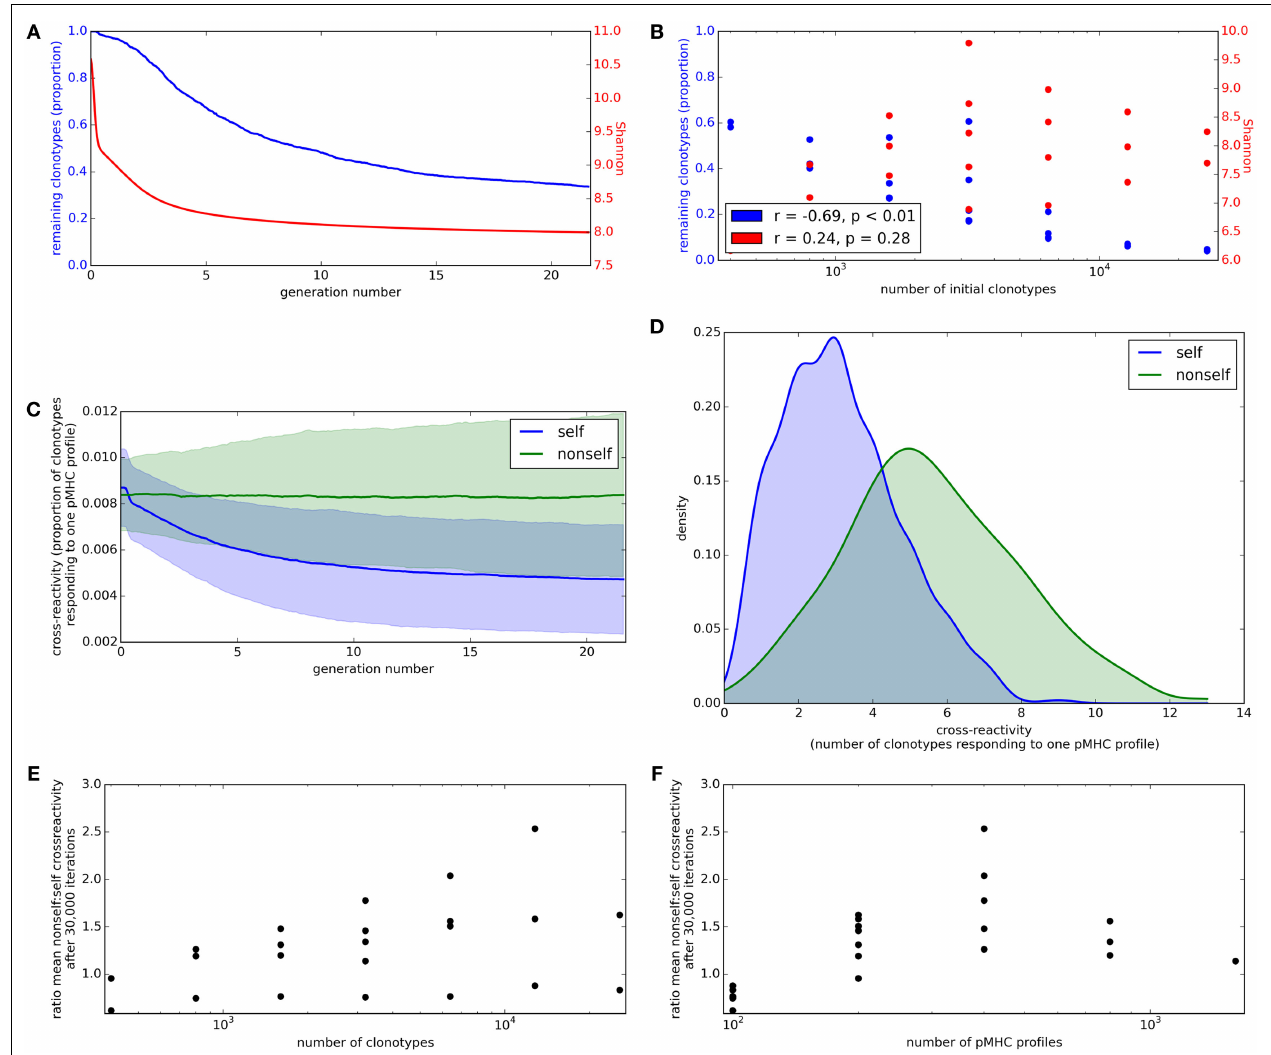
FIGURE 4 | Clonotype diversity and pMHC profile cross-reactivity are preserved by the update algorithm . (A) Blue: The proportion of clonotypes (after positive selection) that are present over time during simulation of the update algorithm. Red: The Shannon entropy of the repertoire over time. Simulation implemented with N = 1,600 and M = 400. (B) Relationship between number of clonotypes in the simulation and proportion of clonotypes remaining (blue) or Shannon entropy of the repertoire (red) after 30,000 iterations of the update algorithm. Simulation implemented with values of N between 400 and 25,600 and M between 100 and 800, with M < N . (C) Cross-reactivity of T cell clonotypes against self (blue) and non-self (green) pMHC profiles over time, run with N = 3,200 and M = 400. Cross-reactivity is measured as the proportion of present clonotypes that have non-zero binding strength for a given profile. Data shown is mean cross-reactivity across all profiles (cid:6) standard deviation.